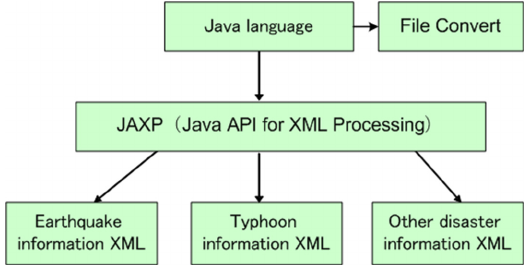
Figure 5. DPI XML data conversion